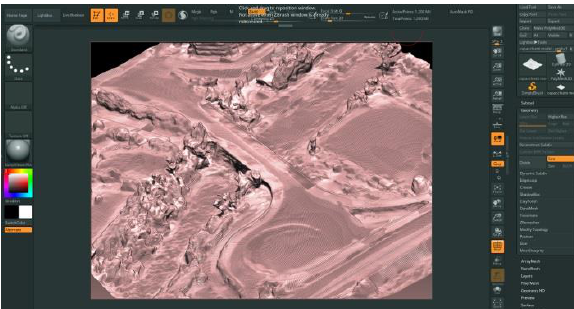
Figure 18: 3d photogrammetric model optimized in Zbrush and retopologized from triangular to